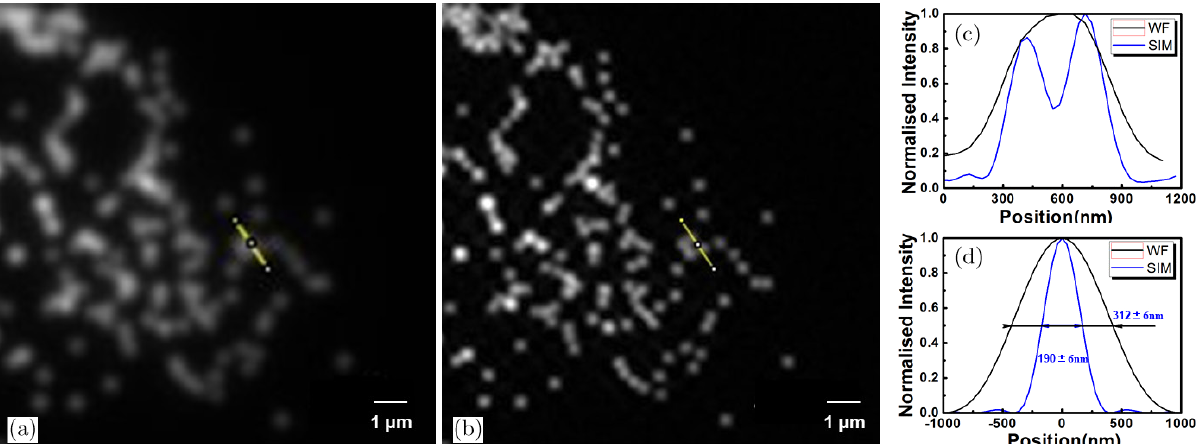
Fig. 6. Characterizing the resolution of the DMD-projection-based SIM system with 50 nm °uorescent beads. (a) Conventional wide-¯eld (WF) image; (b) reconstructed SIM super-resolution image; (c) line pro¯le of two neighboring beads which are not distinguishable in WF but clearly separated in SIM; (d) line pro¯le of a single beads shows the FWHM in SIM is 1 : 6 (cid:1) times smaller than that in